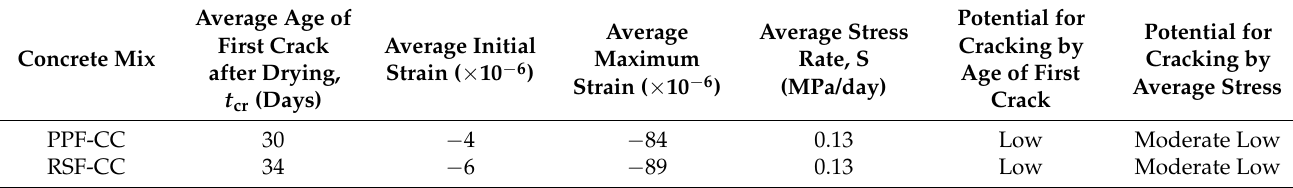
Table 5. Potential for cracking of the studied fiber reinforced